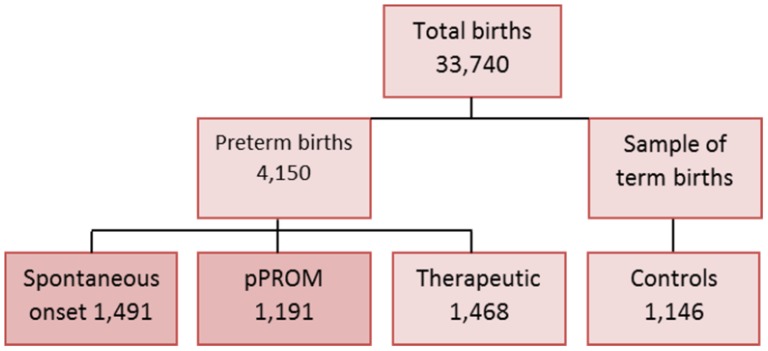
Flow chart of births in the Brazilian Multicentre Study on Preterm Birth.